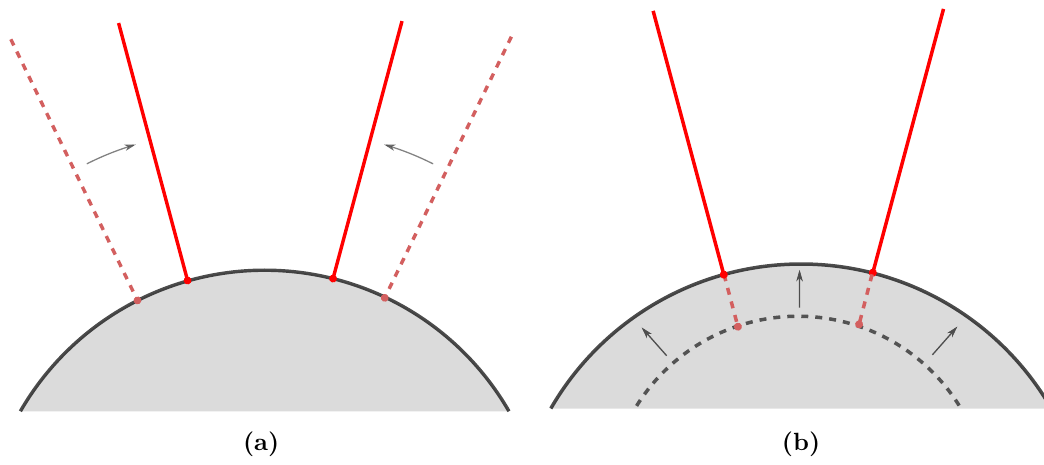
Figure 2. Effect of gravity and expansion of the shell on four dimensional matter. Radially stretched strings gravitate towards each other while remaining radial, as shown in (a). Their end points trace four dimensional geodesics, behaving like matter particles on the shell. In the limit where the gravitational attraction between them can be ignored, the expanding shell “eats up” the strings and the four dimensional matter represented by their end points seem to move away from each other, corresponding to the expansion of the universe. This is shown in